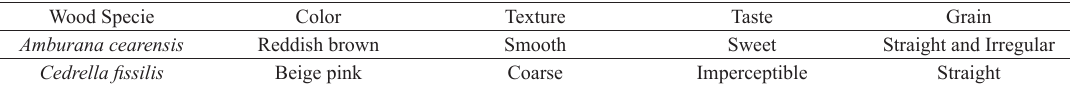
Table 1. Organoleptic properties of Brazilian tropical hardwoods.